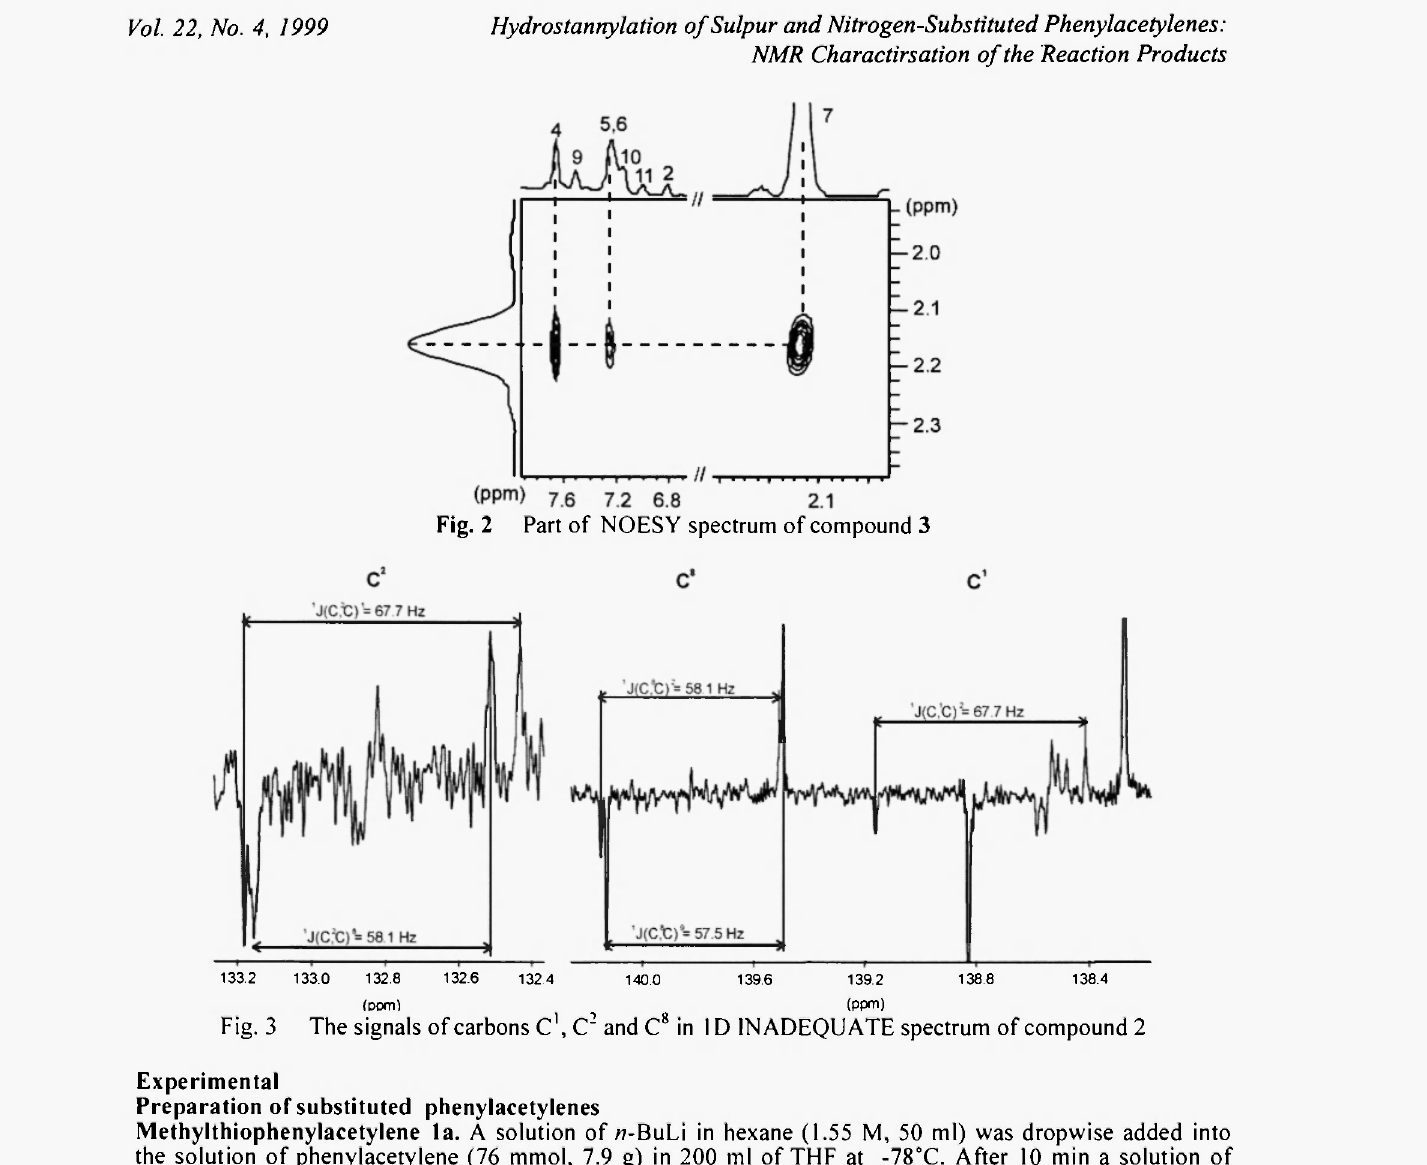
The signals of carbons C 1 , C : and C 8 in ID INADEQUATE spectrum of compound 2